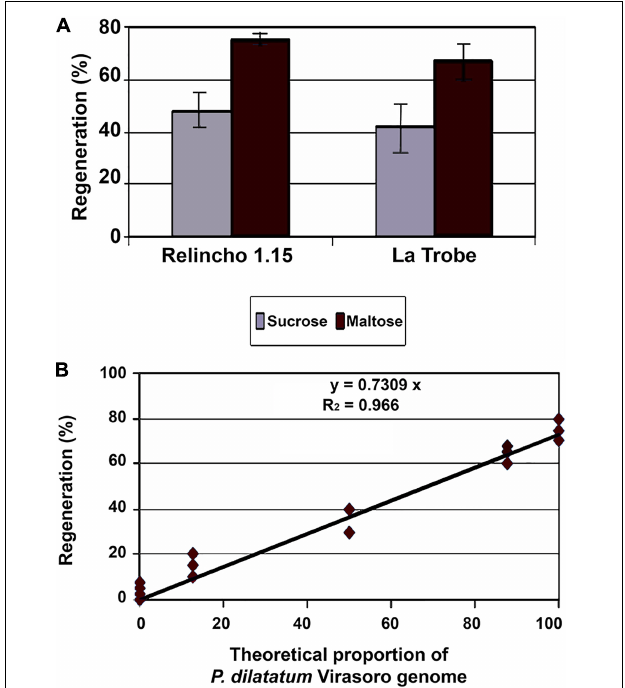
FIGURE 1 | Effects of type of carbon source and genetic variation upon regeneration. (A) Estimated regeneration frequencies through the ratio number of regenerated explants or number of proliferated explants, of two apomictic genetic materials (Relincho 1.15 and La Trobe) grown in induction and proliferation media with sucrose or with maltose (differences between media within genotypes were significant through the G -test ( p < 0.05). Source: Schrauf (2009). (B) Regeneration of EC from progeny derived from interspecific crosses between P. dilatatum (Virasoro) and P. urvillei. Linear association between theoretical proportion of Virasoro and regeneration. Source: Schrauf (2009).